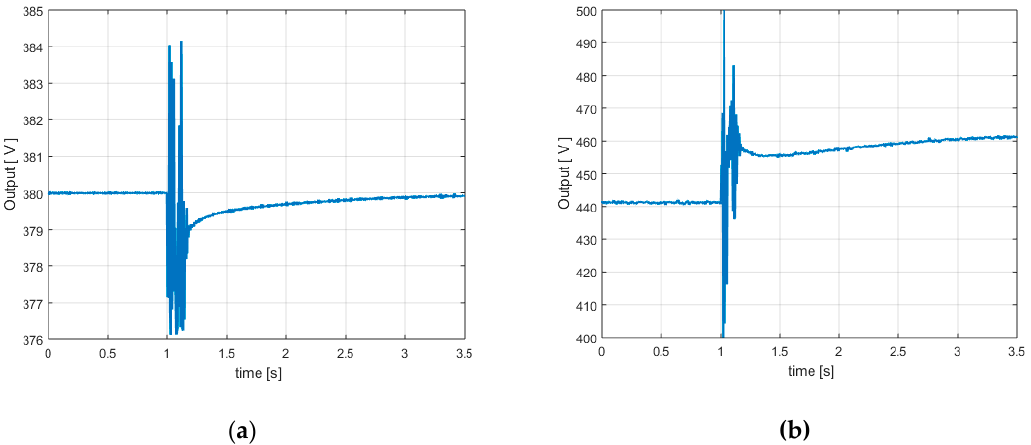
Figure 4. Mechanical torque variation—5th order model: ( a ) Terminal voltage (controlled output); ( b ) Excitation voltage (controller output).